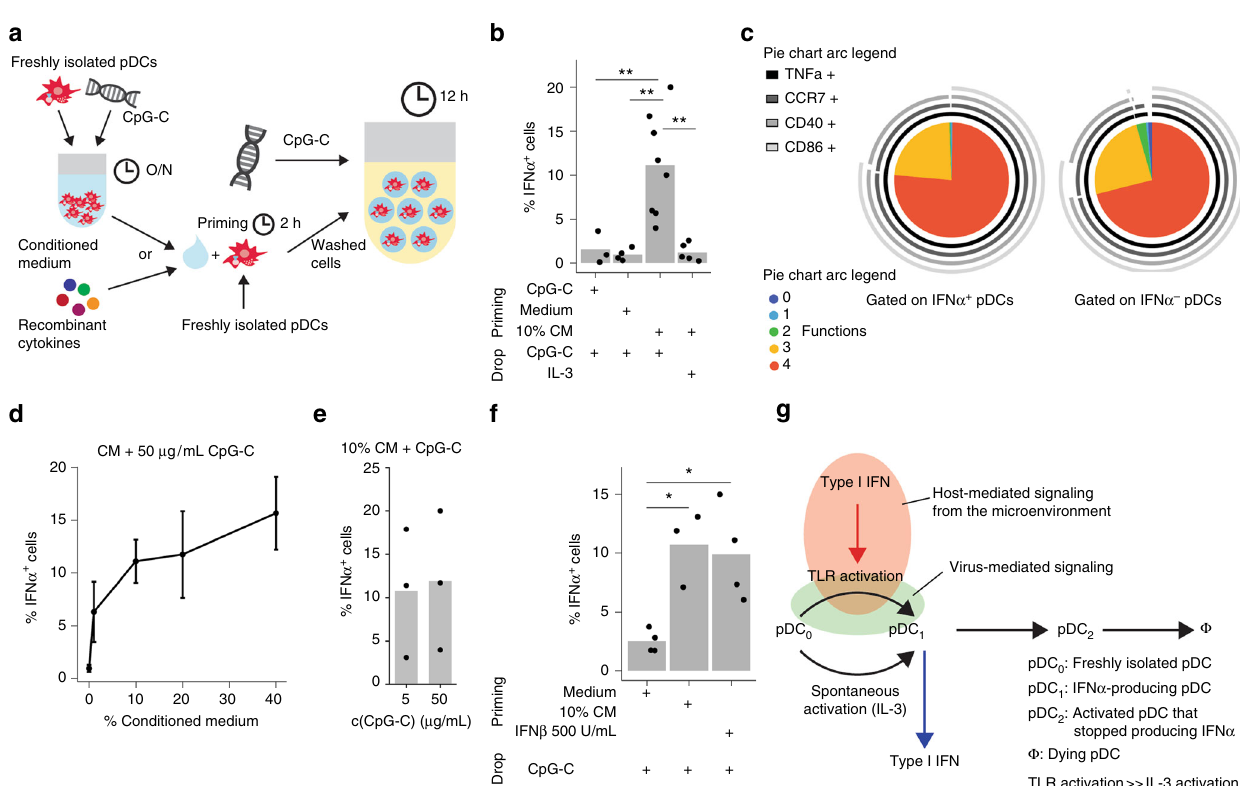
Fig. 6 The pDCs primed with CM or IFN β are more likely to produce IFN α . a Schematic overview of the priming experiment. The pDCs were stimulated for 2 h with conditioned medium (CM), 0.5 µ g/mL CpG-C, or control medium. Cells were washed, coated with cytokine capture reagent, encapsulated in droplets, and stimulated individually with 0.01 µ g/mL IL-3 or 50 µ g/mL CpG-C for 12 h. CM was generated from bulk pDC cultures stimulated with 5 µ g/ mL CpG-C at a density of 25,000 cells/well. Cytokine-secreting cells were detected using fl ow cytometry. b The fraction of IFN α -secreting cells is plotted against different treatment conditions. c Co-expression of CCR7, CD40, CD86, and TNF α by single IFN α + and IFN α − pDCs was analyzed. Shown is the relative contribution of each functional response pattern to the total pDC population. d The pDCs were primed with different concentrations of CM and stimulated with 50 µ g/mL CpG-C. Shown is the fraction of IFN α -secreting cells plotted against CM concentration; n > = 3. Dots indicate mean and whiskers indicate SEM. e The pDCs were treated as described above, primed with 10% CM, and stimulated with different concentrations of CpG-C.